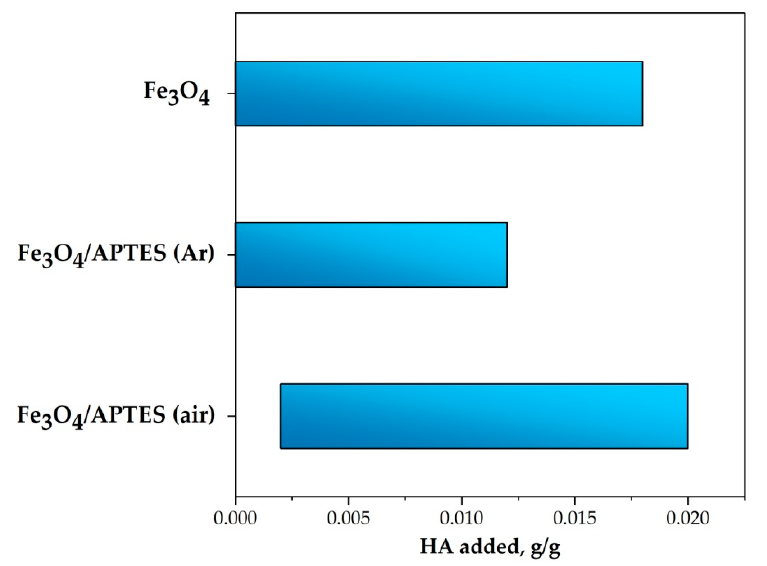
Figure 9. Range of amount of HA for unstable systems, g/g (pH ∼ 5 and KCl = 0.01 M) ( p -value < 0.05). ( p -value <